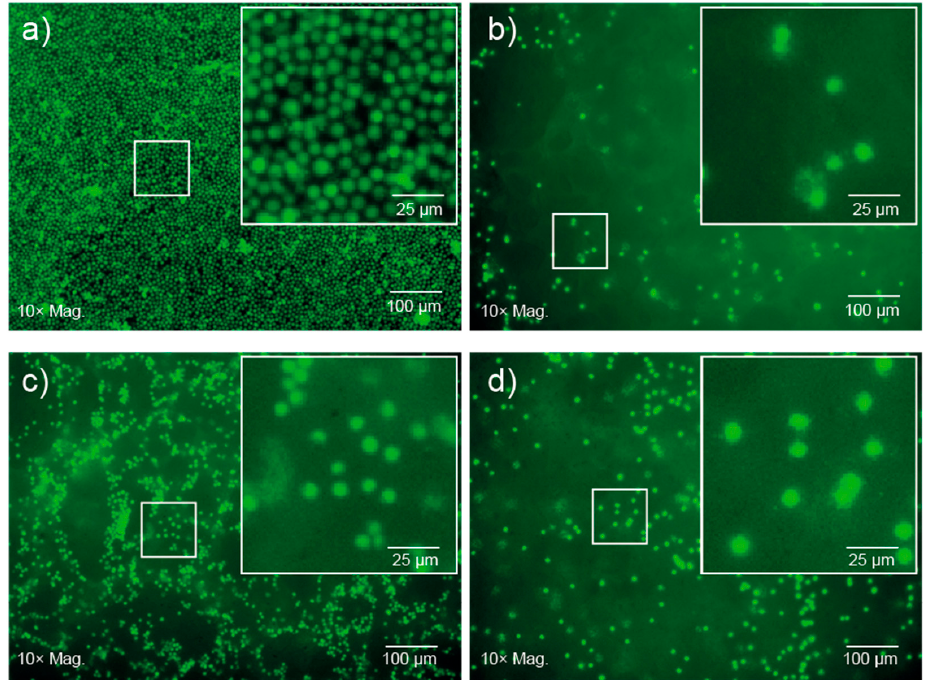
Figure 6. Fluorescence microscopy images of CD4 + T-cells after 24 h ( a ) on well plates at a cell density of 1 × 10 6 cells · mL − 1 , and encapsulated in 10 wt% PEG 1 PPG 2 copolymer gels at cell densities of ( b ) 1 × 10 6 and ( c ) 5 × 10 6 cells · mL − 1 and 15 wt% PEG 1 PPG 2 copolymer gel at a cell density of ( d ) 1 × 10 6 cells·mL − 1 .